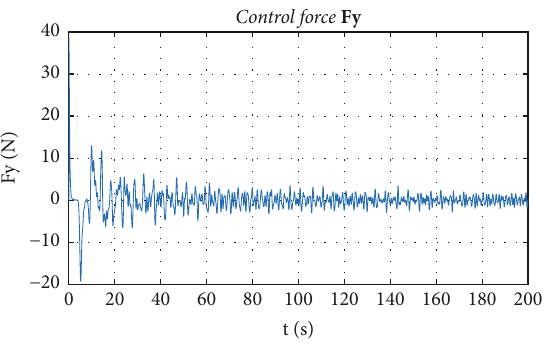
Figure 5: Control force 𝐹 𝑦 without vibration control.